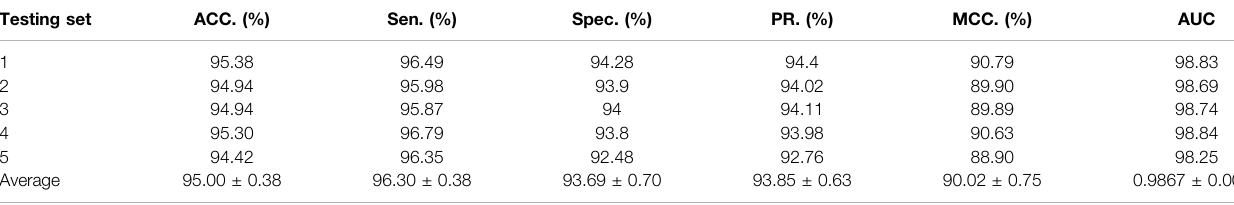
TABLE 2 | Prediction performance on the Zea mays dataset with the multiple feature. Testing set